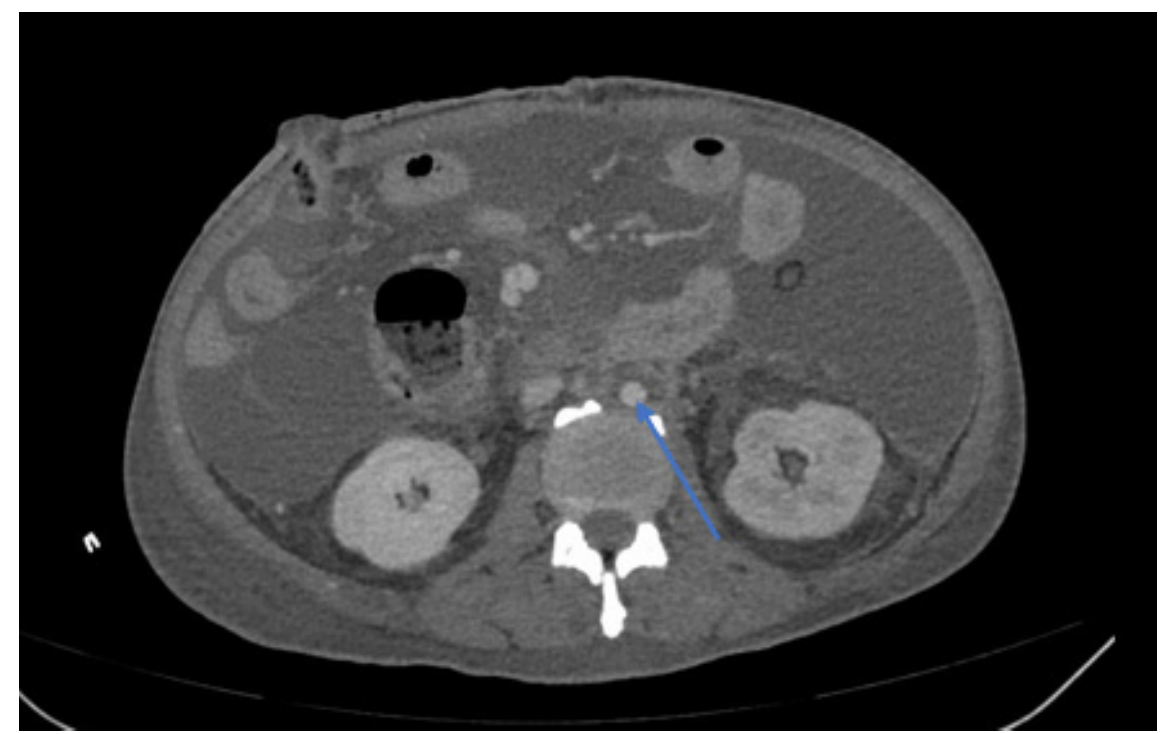
Figure 3. Post-operative CTA image of an abdominal stent graft infection in patients who underwent ISR and subsequent stent graft removal. CTA image at 6 months after ISR surgery indicated that the autologous vein graft was patent (blue arrow).